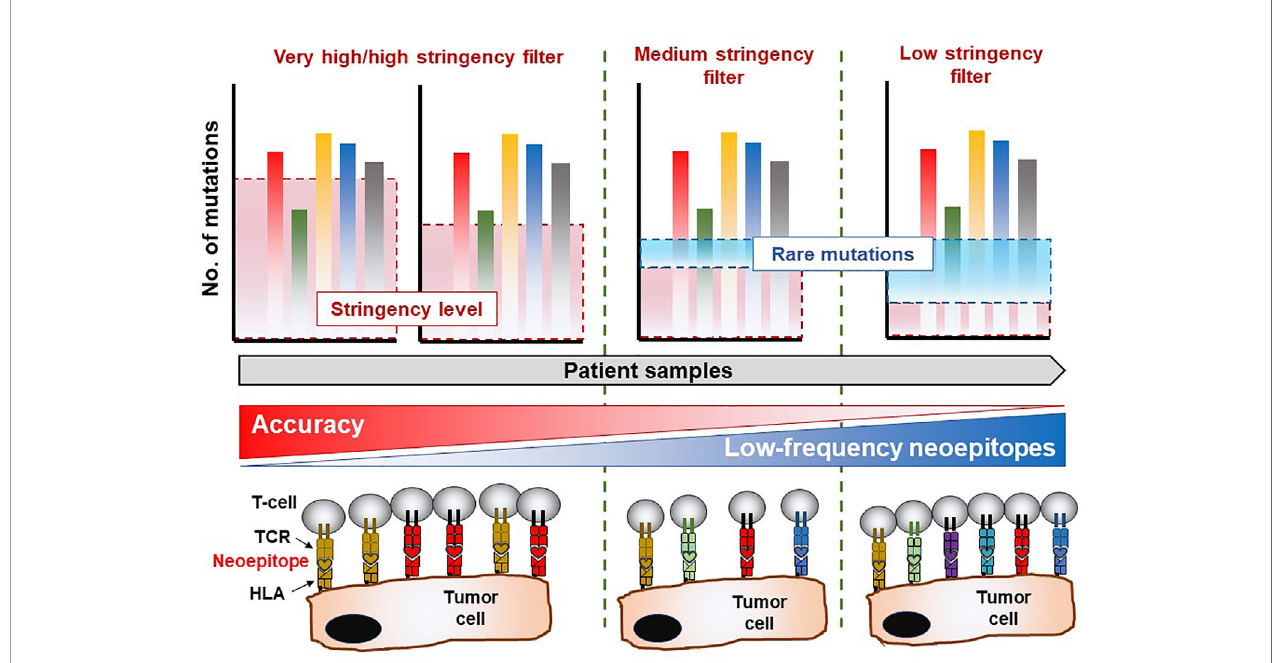
FIGURE 1 | Mutation analysis reveals immune-recognition pro fi le in the TME. Whole-exome sequencing data allows for mining of private somatic mutations in tumor samples compared to healthy (non-transformed) tissue or cells, which is unique to each patient. The stringency of the fi ltering parameters applied in bioinformatics and statistical analysis of the sequencing data will greatly in fl uence the number of mutations recovered, which are essential for downstream characterization of immune responses of T-cell products. Highly stringent parameters may yield a lower number of mutations albeit with an exceptional level of accuracy. Nevertheless, this approach suffers the risk of overlooking several infrequent mutations which also give rise to immunogenic (T-cell reactive) neoepitopes in the patient. On the contrary, reducing the stringency levels of analysis may reveal rare mutations which facilitate the identi fi cation of potentially immunogenic molecular targets recognized by certain TCRs capable of eliciting a biologically relevant anti-tumor immune response. The drawback in the latter scenario is that a high degree of false positive hits may be obtained and included in the fi nal list of legitimate cancer-associated somatic mutations. Thus, a balanced yet wholistic approach is required to identify all immunogenic mutations in tumor tissue which will be instrumental in developing personalized cancer